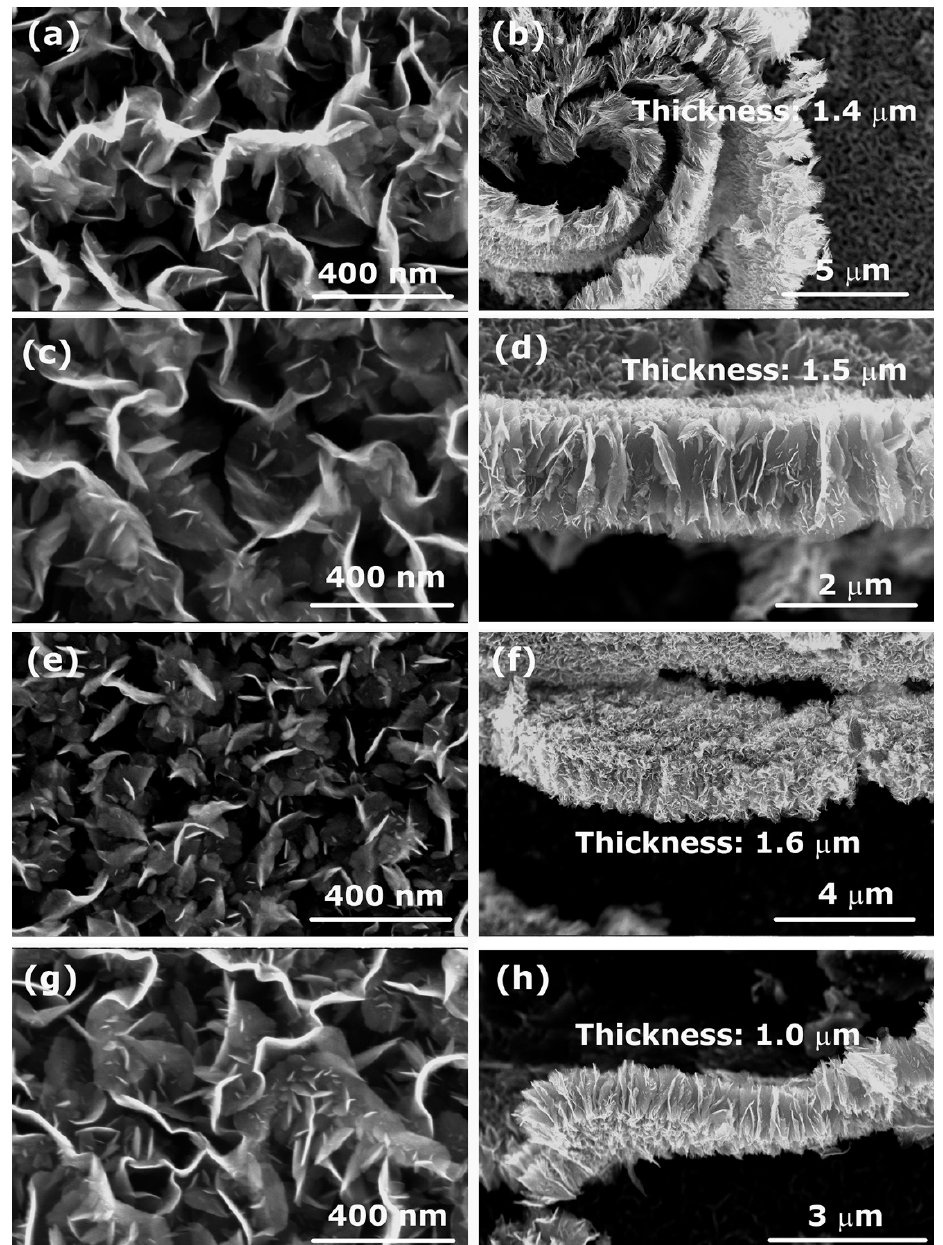
Figure 7. SEM images of CNWs (left) and their cross-section (right) synthesized from the aliphatic PP polymer in plasma created in: ( a , b ) O 2 , ( c , d ) H 2 , ( e , f ) N 2 , and ( g , h ) CO 2 gas. Deposition time was 60 s. Table 4. XPS surface composition of the deposits synthesized from PP polymer using various gase- ous discharges.